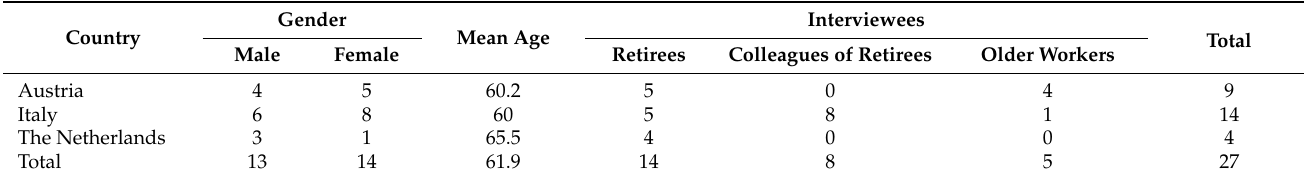
Table 2. Participants to the telephone follow-up interviews per